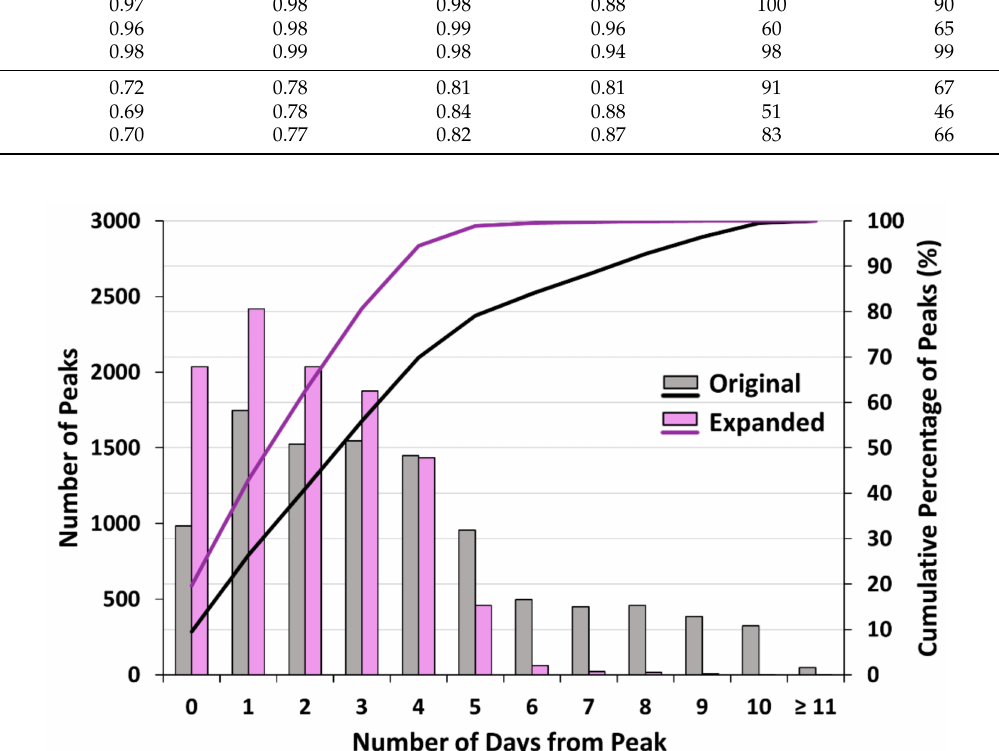
Figure 9. The number of peak flows greater than the 75th percentile for daily gauge time series and the corresponding number of days between the event peak and a SWOT observation for both the original and expanded time series. The count and cumulative percentage of each are